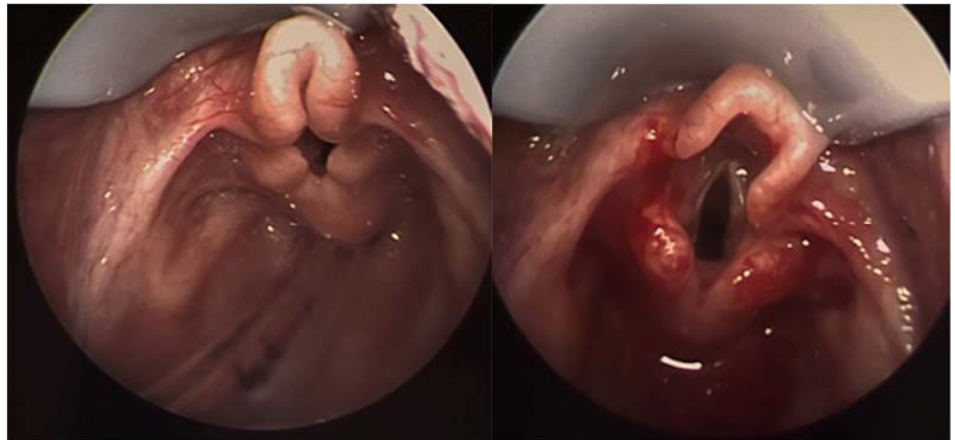
Figure 1. Laryngoscopy image showing significant laryngomalacia. Note the curled appearance of the airway with obstruction of the glottis. The image on right demonstrates the same patient immediately after supraglottoplasty.